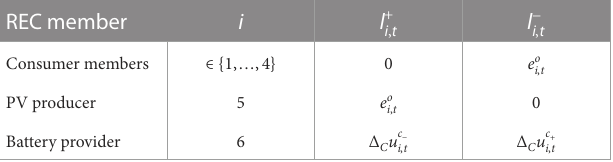
TABLE2 NetelectricityproductionandconsumptionofRECmembersfor